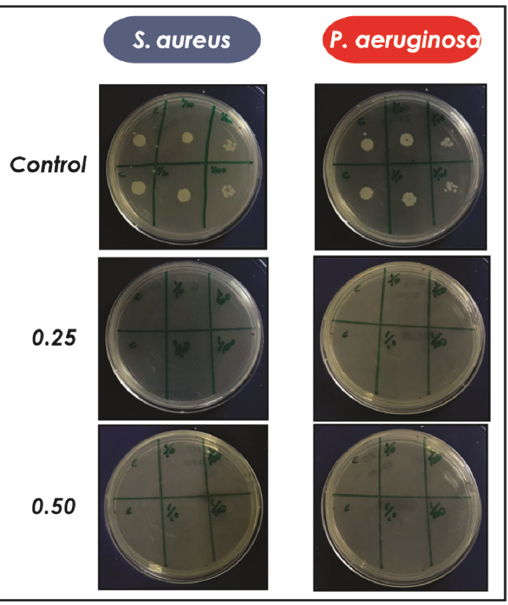
Figure 2. Antimicrobial activity of AgNPs against S. aureus and P. aeruginosa for different ratios